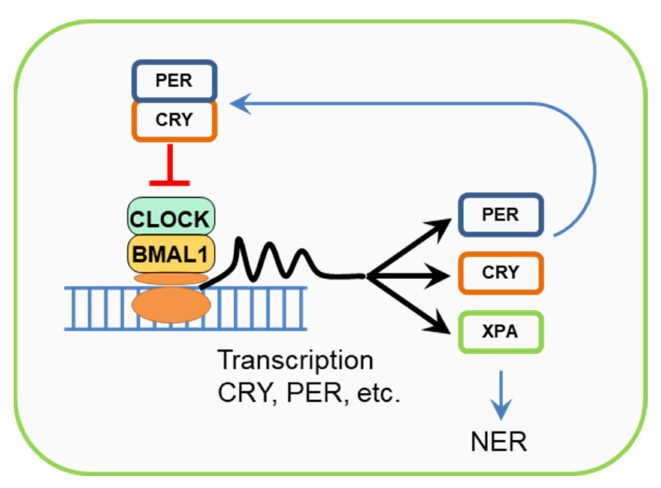
Figure 4. Mechanism of the mammalian circadian clock. CLOCK and BMAL1 are transcription activators of Cry and Per genes. CRY and PER are transcriptional repressors. They inhibit their own transcription, thus causing the rise and fall of CRY and PER levels with 24-h